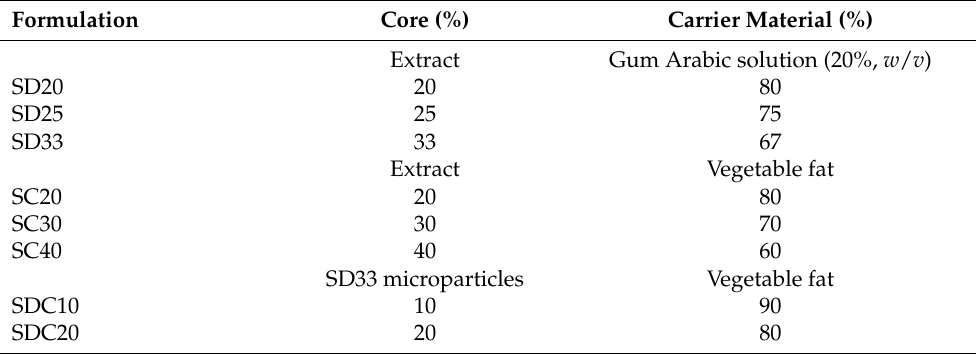
Table 1. Formulation and composition of microparticles produced by spray drying (SD), chilling (SC), and the combination of spray drying and chilling